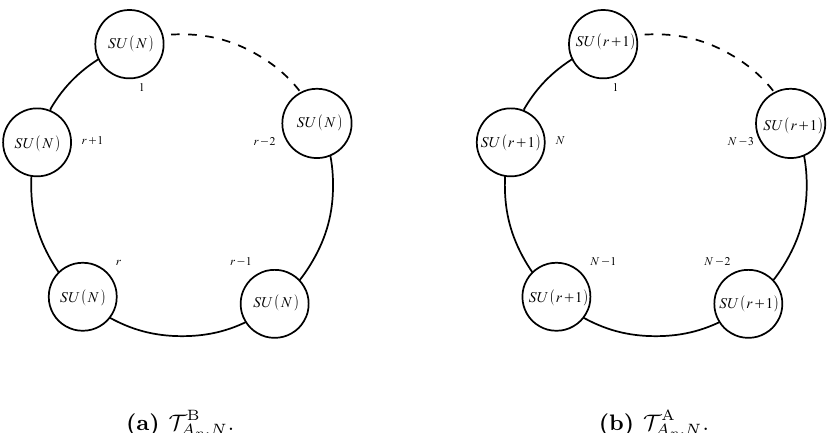
Figure 6. The (cid:12)ber-base duality for the case g = A r . The nodes in each diagram are connected by free bi-fundamental